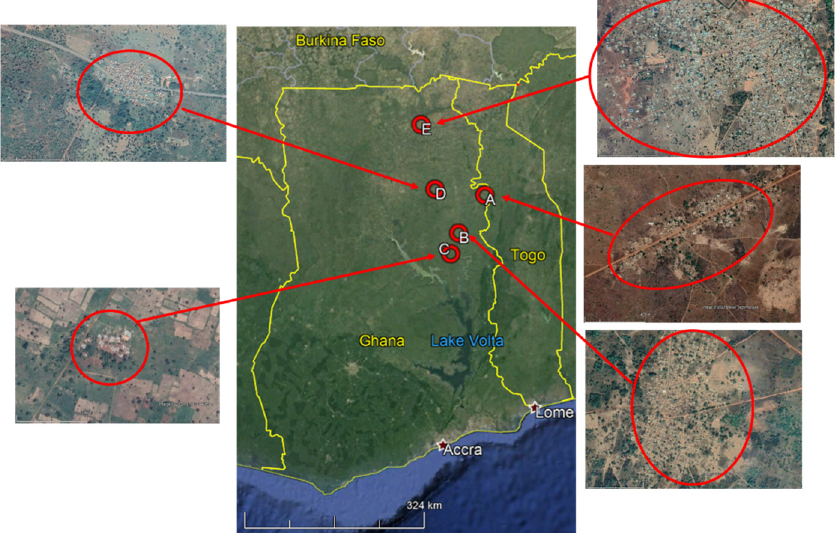
Figure 1. Physical map of Ghana with the location of the five villages investigated (from Google Earth Pro on desktop).